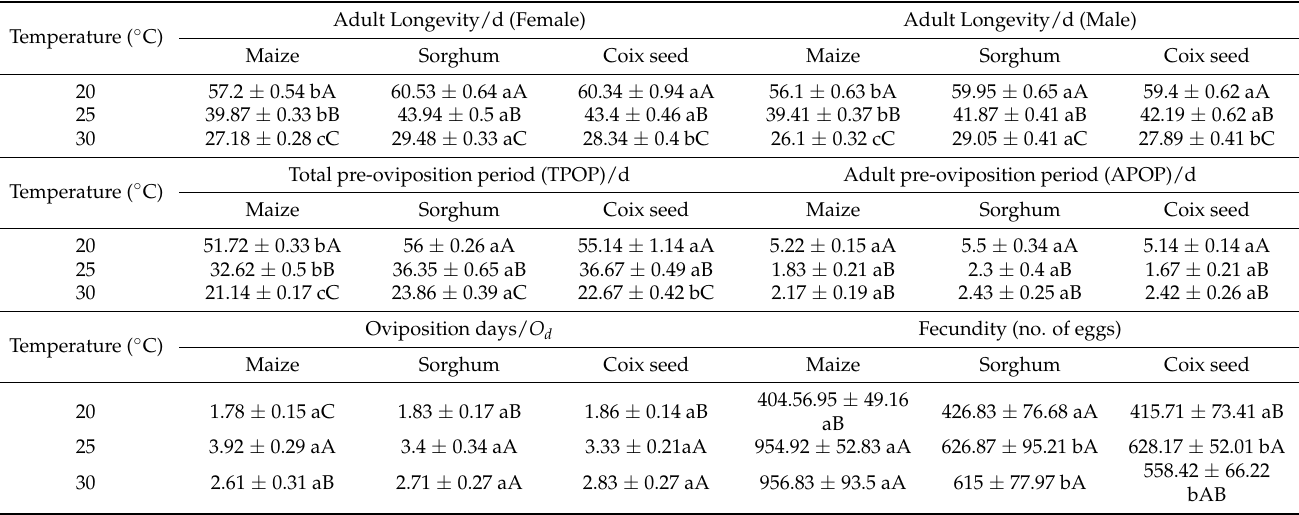
Table 3. Adult longevity and reproductive parameters mean ( ± SE) of Spodoptera frugiperda reared on different host plants under different